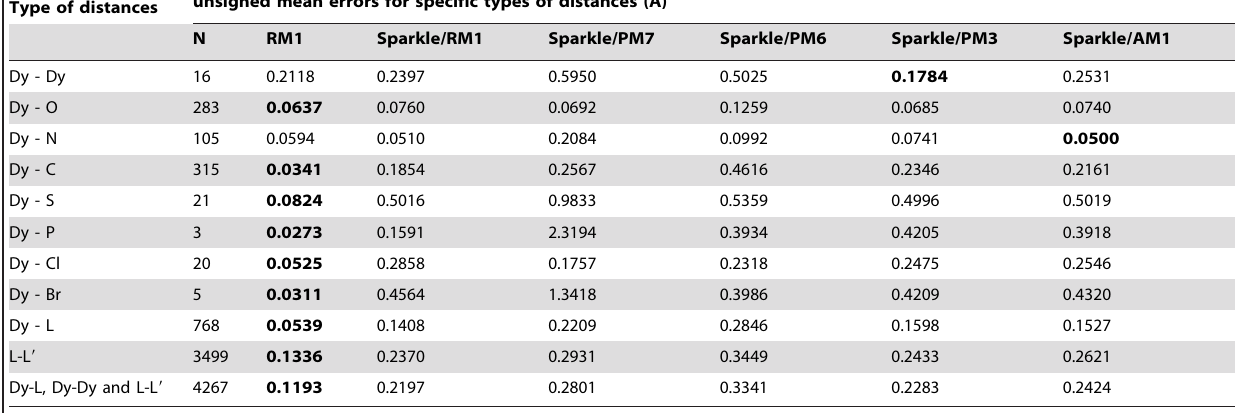
Table 7. RM1, Sparkle/RM1, Sparkle/PM7, Sparkle/PM6, Sparkle/PM3, and Sparkle/AM1 unsigned mean errors for different types of distances of dysprosium(III)